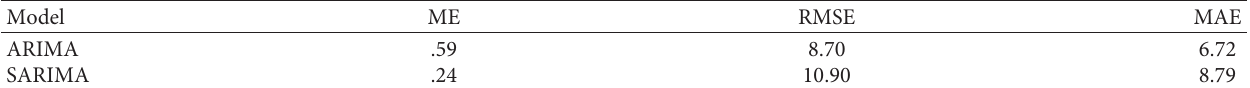
Figure 19: Diagram comparing actual energy data with seasonal ARIMA forecasted energy data of January for the year 2018. Table 2: Forecasting model performance for Daewoo Steel Factory data set for ARIMA and SARIMA.